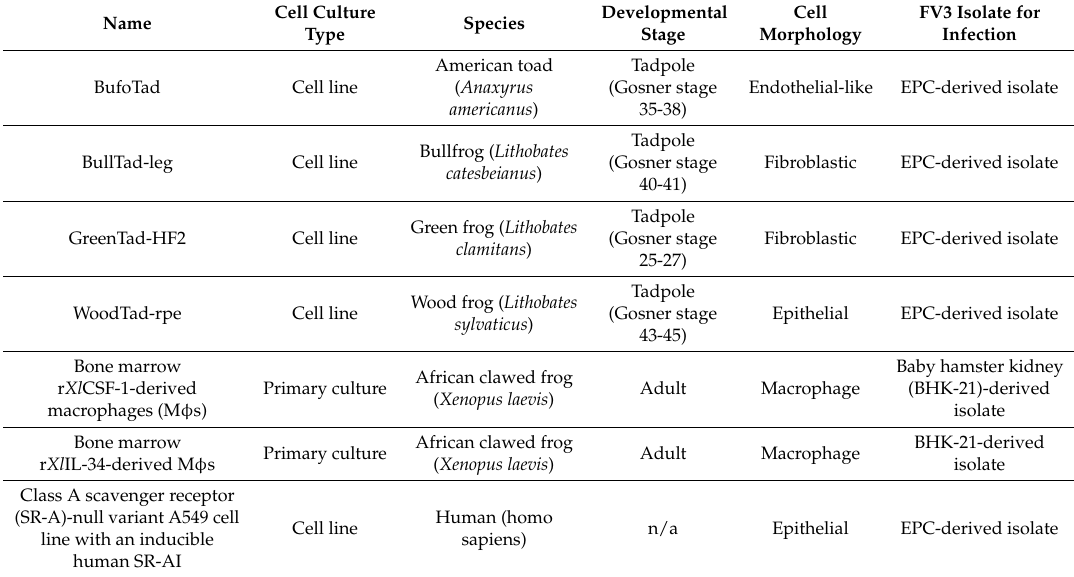
Table 1. Cell lines and primary cultures used for frog virus 3 (FV3) infection.